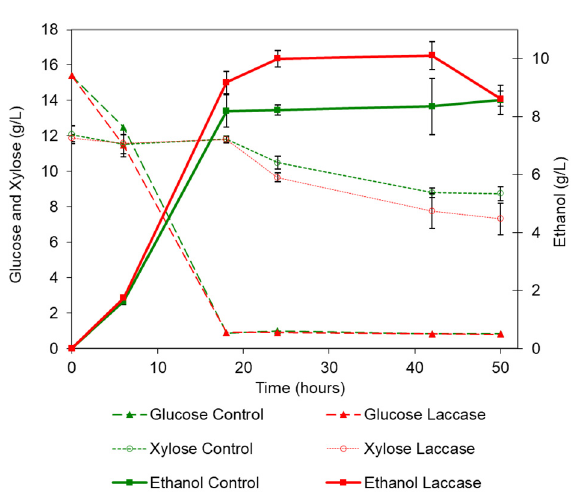
Figure 5. Time course for fermentation of control and laccase-treated liquid fraction enzymatic hydrolysates using S. cerevisiae F12. Concentrations (g/L) of glucose and xylose and production (g/L) of ethanol are shown.